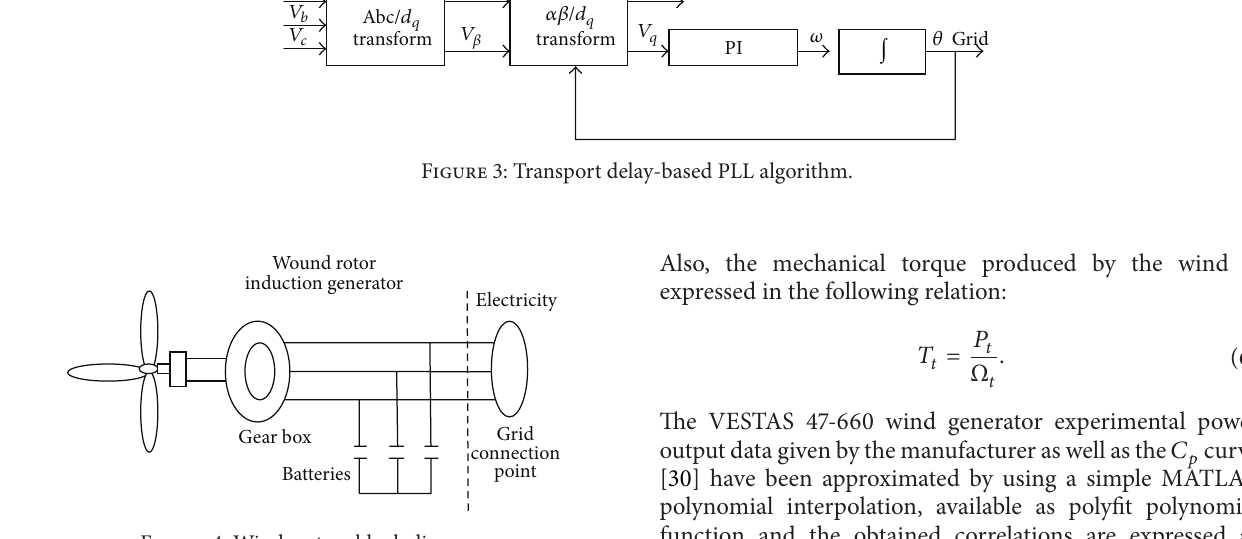
Figure 4: Wind system block